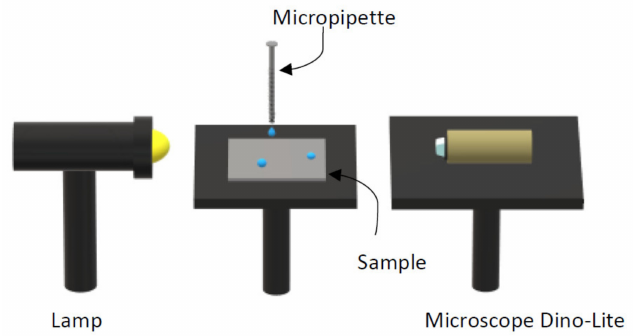
Figure 2. Schematic diagram of the contact angle measurement system.